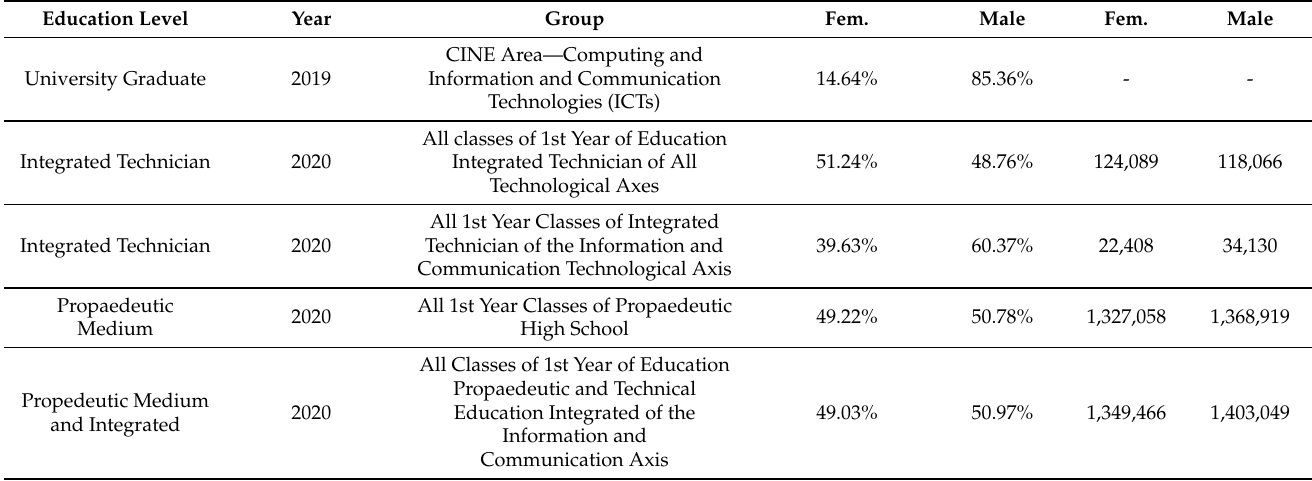
Figure 3. Data from the 2015-2019 Annual List of Social Information (RAIS) on the performance of men and women in specialized positions. Table 3. Percentage between men and women enrolled in various teaching modalities, considering the School Census and the Higher Education